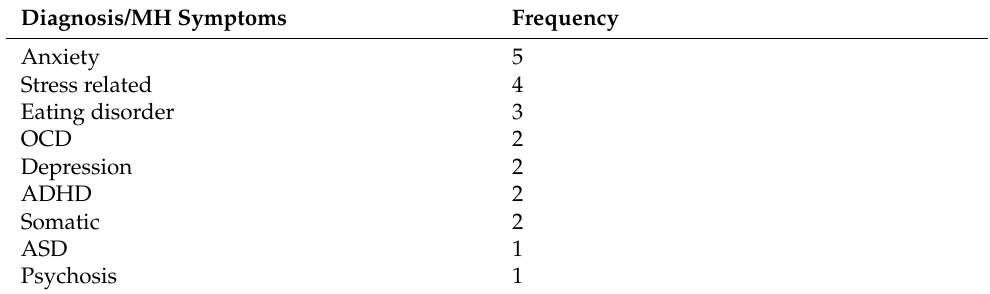
Table 2. Tally of relevance to CHIME processes.